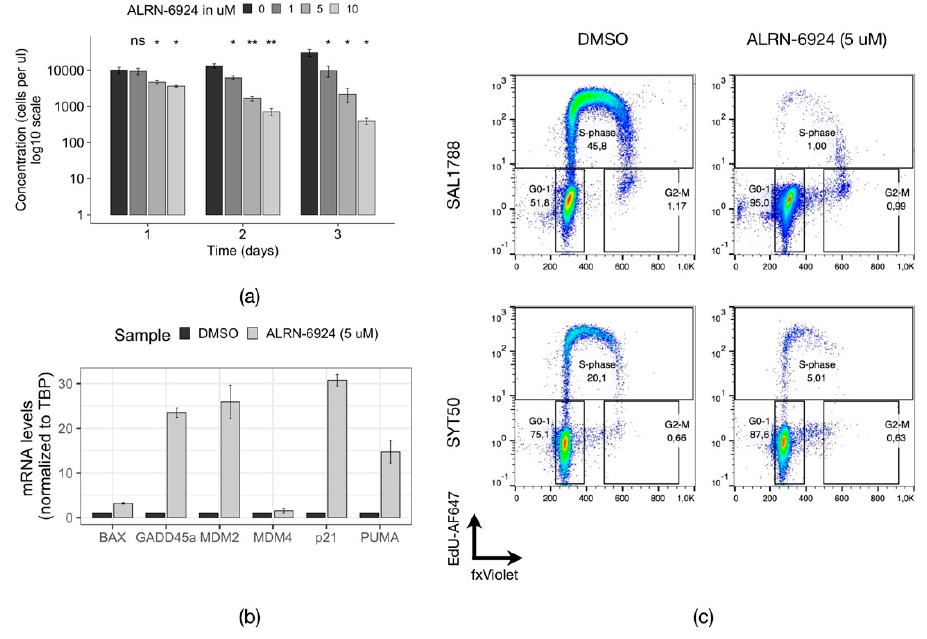
Figure 5. Effects of MDM2/4 inhibition in primary DNMT3A WT/R882 AML cells. ( a ) Normalized counts of live primary AML cells (SAL1788) after the treatment with indicated concentrations of ALRN-6924 ( n = 2). The samples were compared to the DMSO treated sample with a parametric two-sided Student’s t-test (*: p ≤ 0.05; **: p ≤ 0.01; ns—non-significant). The error bars represent the standard deviation of the mean. ( b ) Relative mRNA expression levels of p53 target genes in SAL1788 patient cells treated with DMSO or with 5 µ M ALRN-6924 for 24 h ( n = 2, a representative plot from one experiment is shown). ( c ) Flow cytometric analysis of the cell cycle distribution in primary AML cells from two patients (SAL1788 and SYT50) treated with DMSO or with 5 µ M ALRN-6924 for 24 h ( n = 2 for SAL1788, a representative plot is shown; n = 1 for